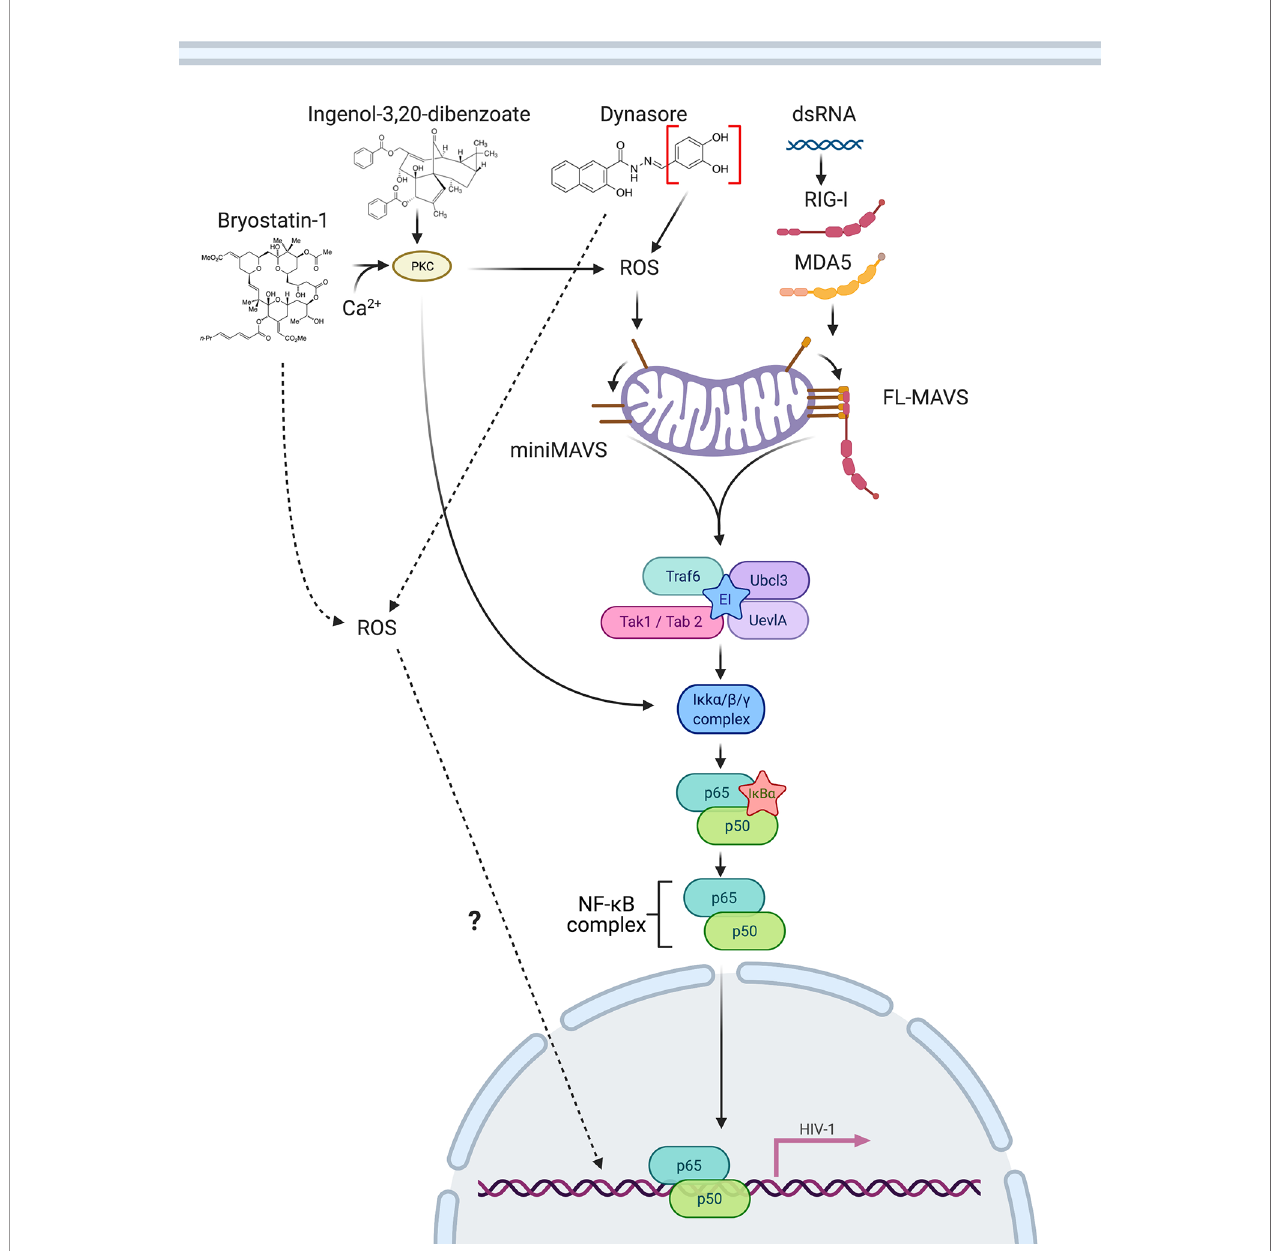
FIGURE 8 | Schematic of MAVS involvement in reactivation of latent HIV-1. RIG-I/MDA5 ligands bind to RIG-I/MDA5 and directly interact with full length MAVS, inducing NF- k B activation. The PKC agonists Bryostatin-1 and Ingenol can trigger NF- k B activation by activating PKC and by inducing ROS, which activates miniMAVS, leading to NF- k B activation, translocation to the nucleus and promoting latency reversal. Dynasore or Catechol mediate ROS generation, activating miniMAVS and causing NF- k B activation. Created with